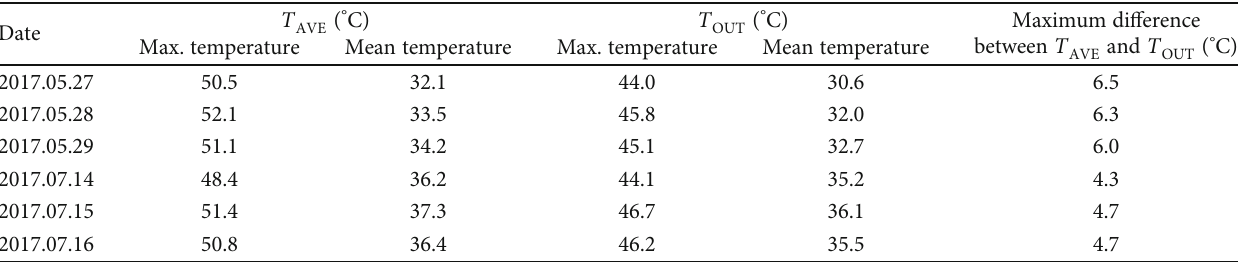
Figure 7: Inner and outer temperature distributions of PV Table 7: Test results of inner and outer temperatures of PV cells.